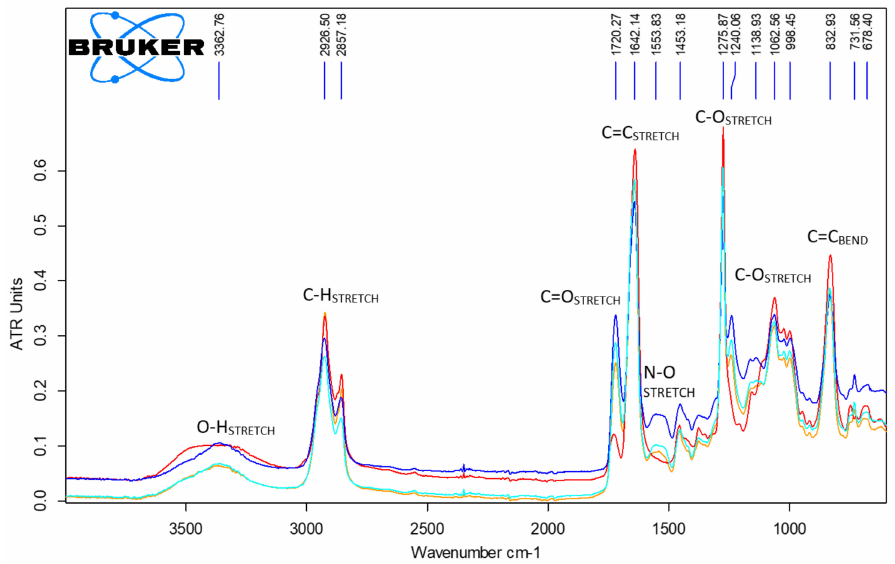
Figure 13. ATR spectra of control ( sheepskin and bovine ) and MWCNT 0.5 samples ( sheepskin and bovine